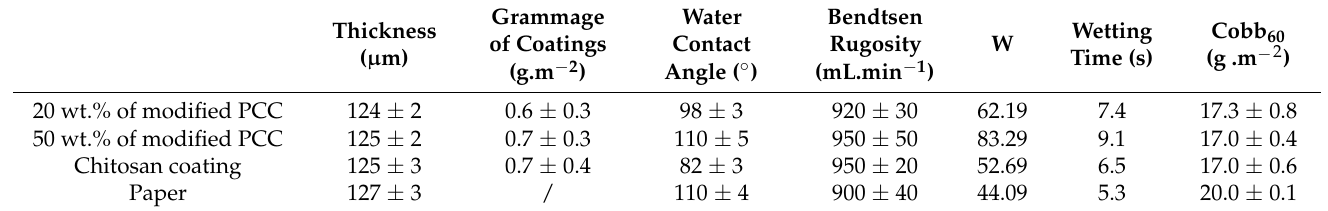
Table 3. Liquid water resistance of coatings evaluated by various physicochemical characterizations.